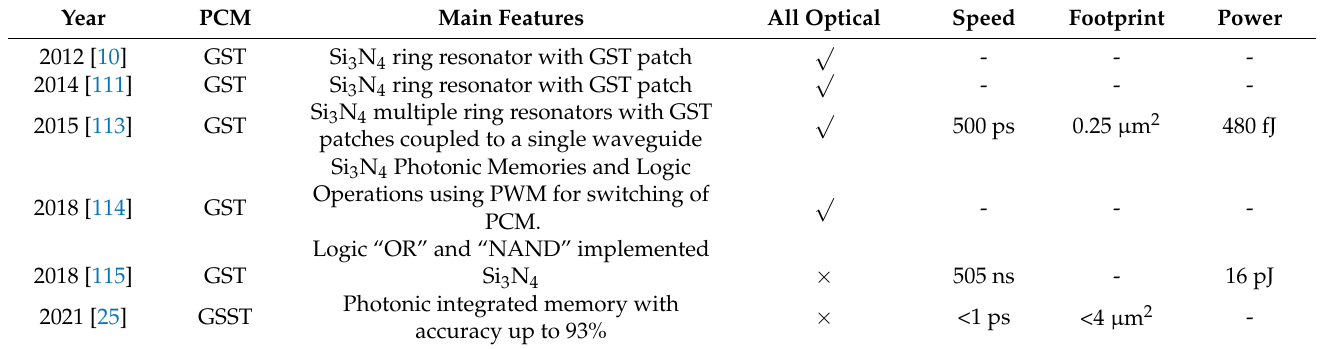
Table 3. Major contributions in memory devices.